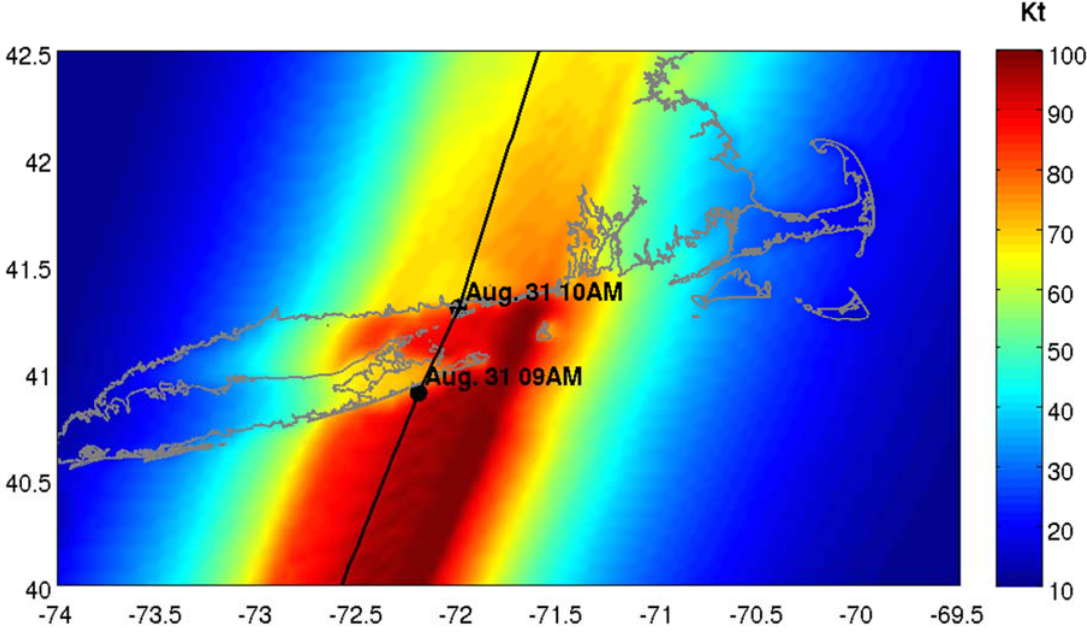
Figure 2. Maximum sustained winds (kt) simulated to have occurred during landfall of 1954’s Hurricane Carol, as obtained from the URI HBL model. Image: Authors.